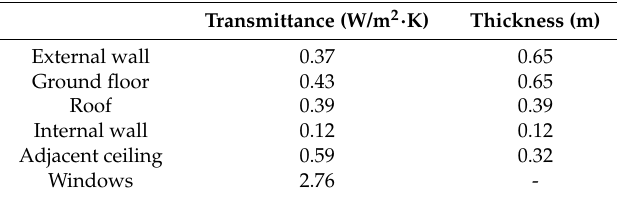
Figure 2. Floor plan and thermal zones of the dwelling.